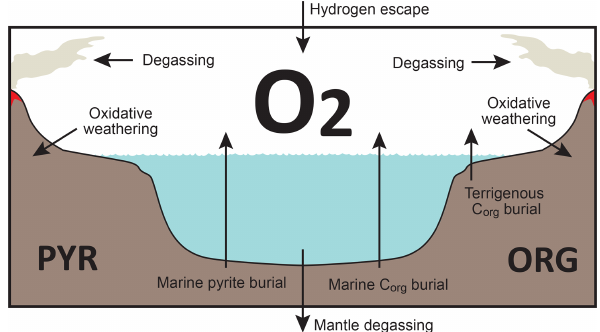
Figure 3. Schematics of global redox (O 2 ) budget. Arrows repre- sent the O 2 flux. The primary source is burial of organic carbon and pyrite sulfur in sediments and hydrogen escape to space. The pri- mary sink is volcanic outgassing and weathering of crustal organic matter and pyrite. PYR is the sedimentary reservoir of pyrite sul- fur. ORG is the sedimentary reservoir of organic carbon. CANOPS- GRB tracks the global redox (O 2 ) budget for each